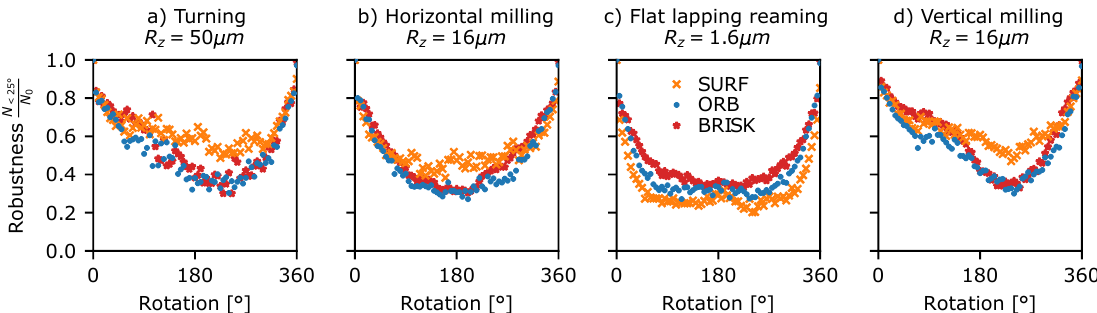
Figure 12. Orientation robustness plotted against rotation angle for a selection of surface treatments shown in Figure 1. ( a ) Turning R z = 50 µ m, ( b ) horizontal milling R z = 16 µ m, ( c ) flat lapping reaming R z = 1.6 µ m, and ( d ) vertical milling R z = 16 µ